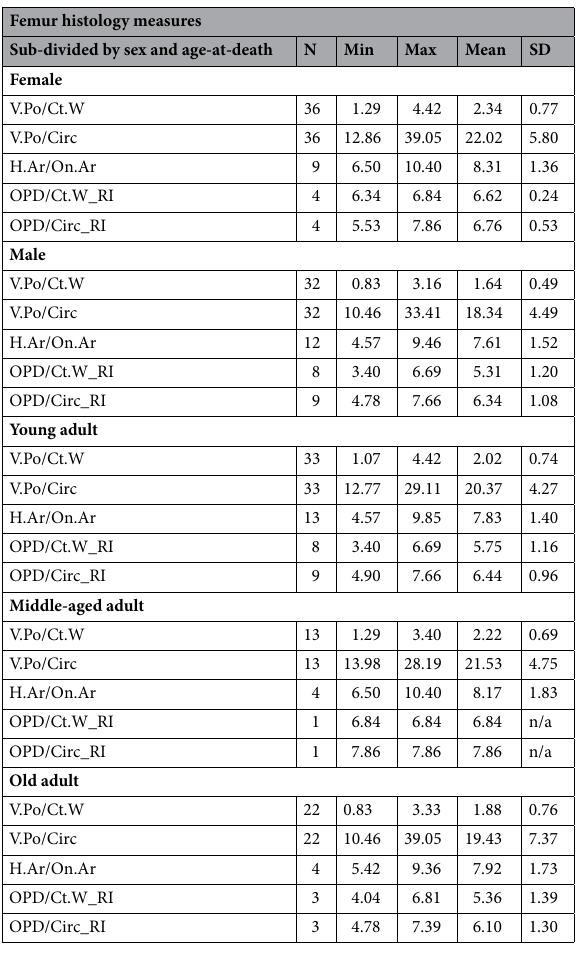
Table 2. Descriptive summary of histology data sub-divided by estimated sex and age-at-death groups. SD standard deviation, MAX. maximum, MIN. minimum, V.Po density of canals/pores per mm 2 , H.Ar/On.Ar ratio of Haversian canal to osteon area in µm 2 , OPD osteon population density per mm 2 , Ct.W_RI robusticity index (RI) calculated using cortical width (Ct.W) data, Circ_RI robusticity index (RI) calculated using midshaft circumference (Circ). All variables are unitless.